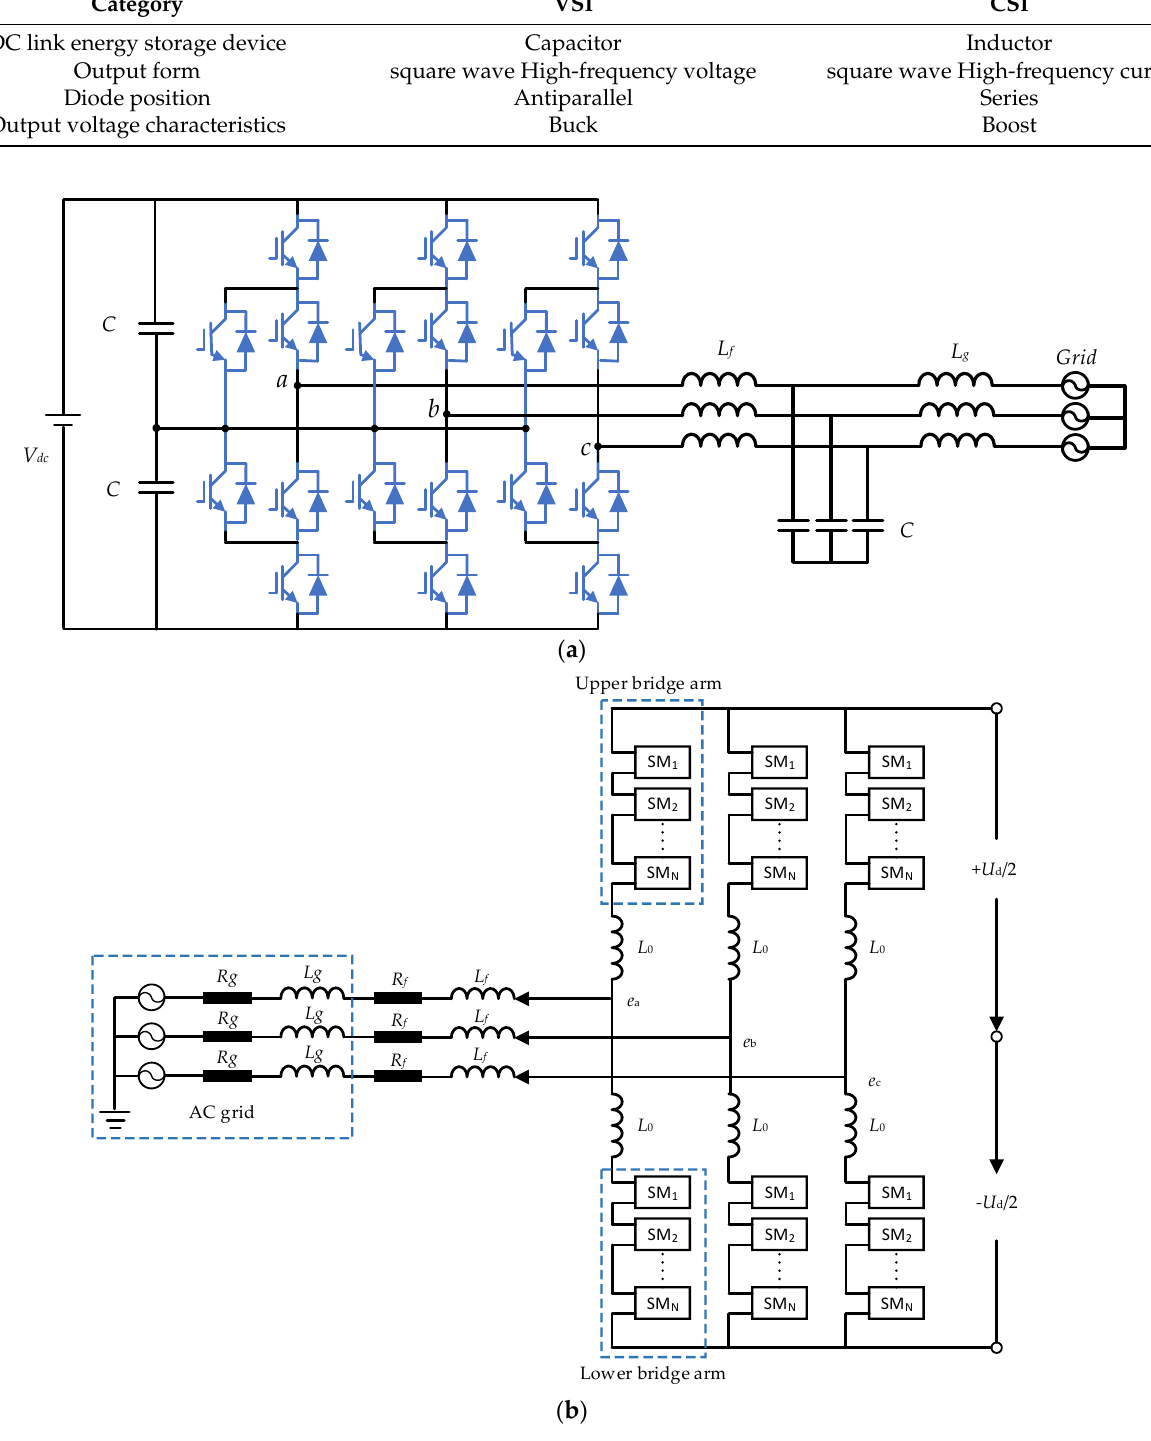
Figure 7. ( a ) The topology diagram of three-phase active NPC. ( b ) The topology diagram of MMC.